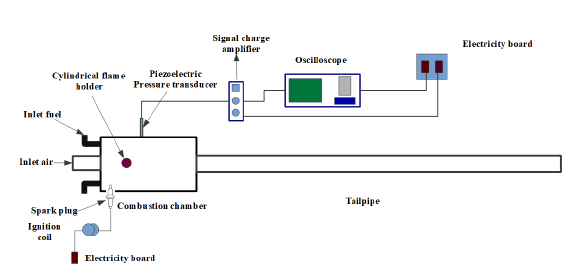
Fig. 1. A schematic of the pulse combustor design and